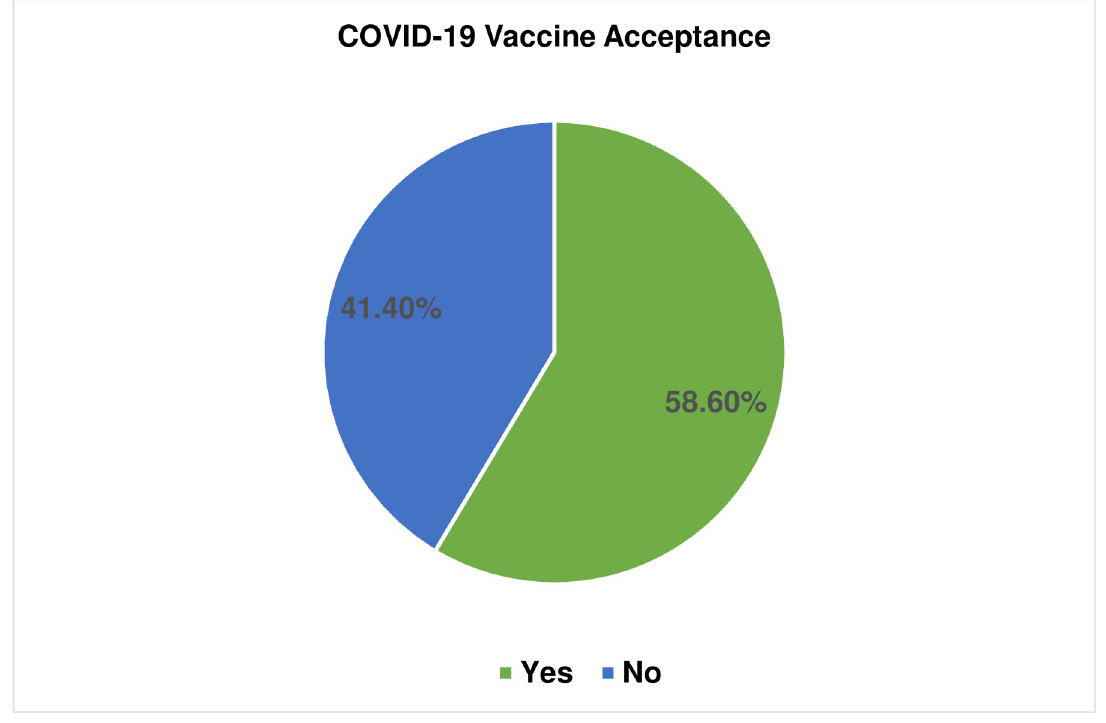
Fig 4. COVID-19 vaccine acceptance among pregnant woman attending antenatal care clinic at Gondar town, Northwest Ethiopia, 2021 (n = 510).